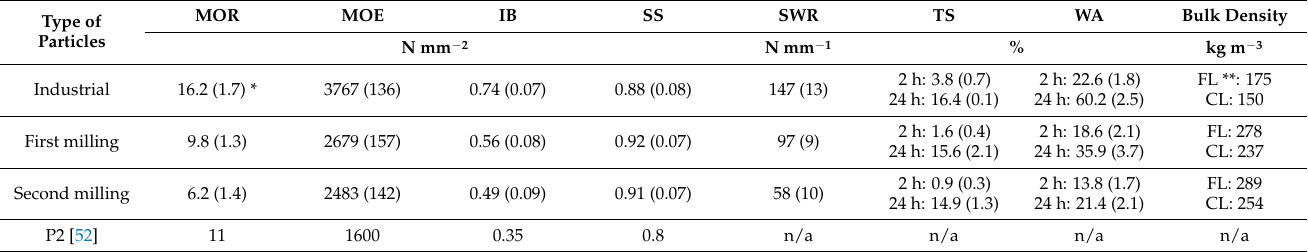
Table 1. The average values and standard deviation of selected research